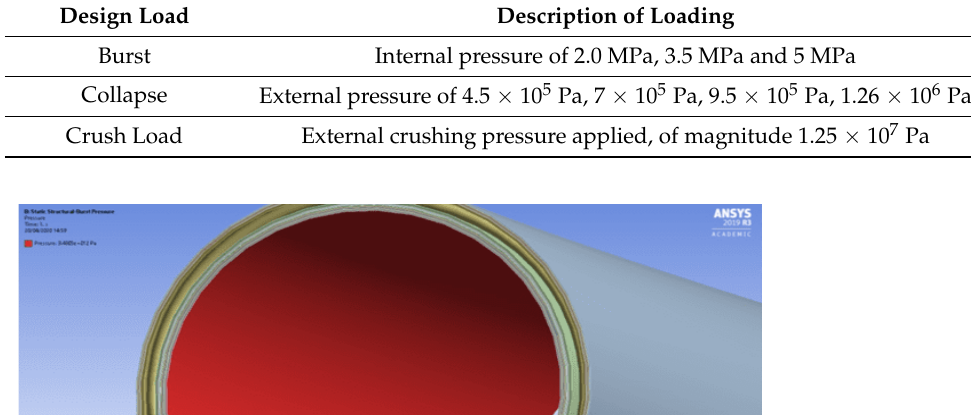
Table 6. Design load conditions.